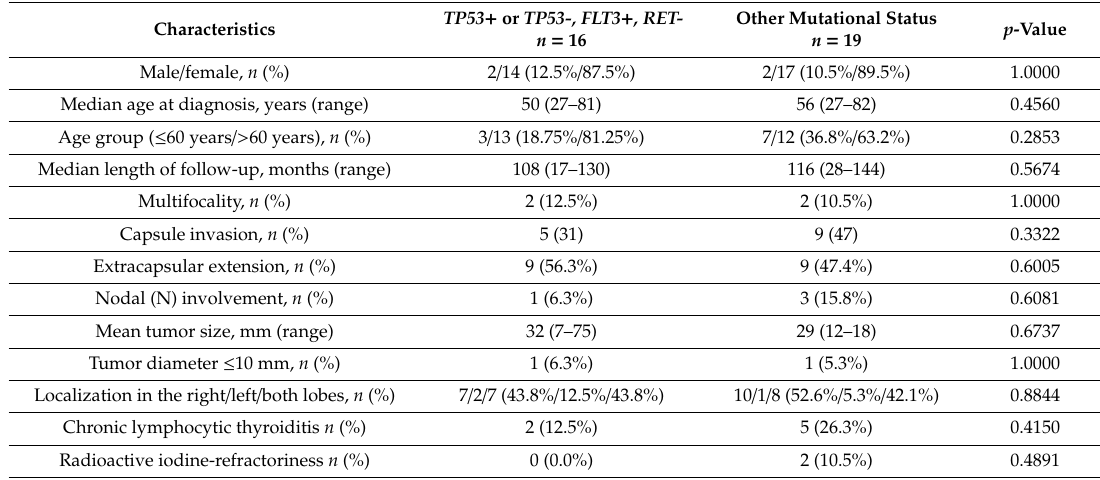
Table 4. The characteristics of patients diagnosed with follicular thyroid cancer according to their mutational